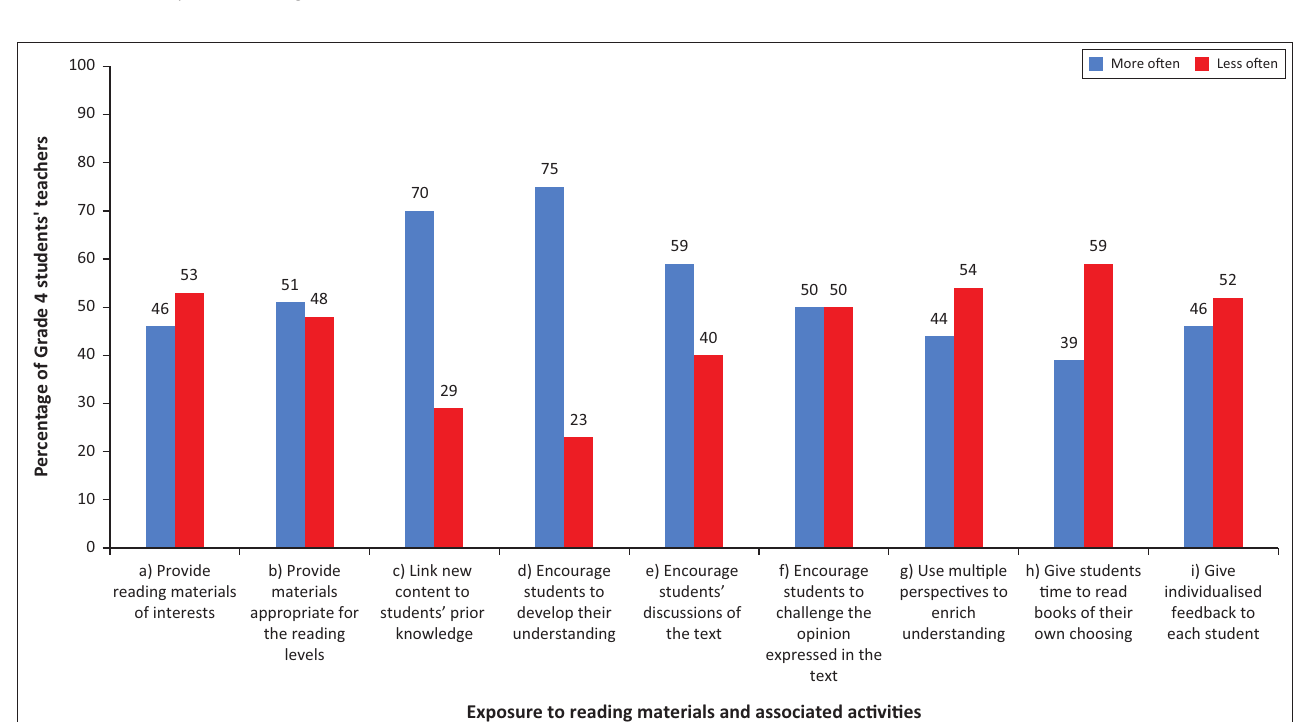
FIGURE 2: Teacher reports on reading activities with students.